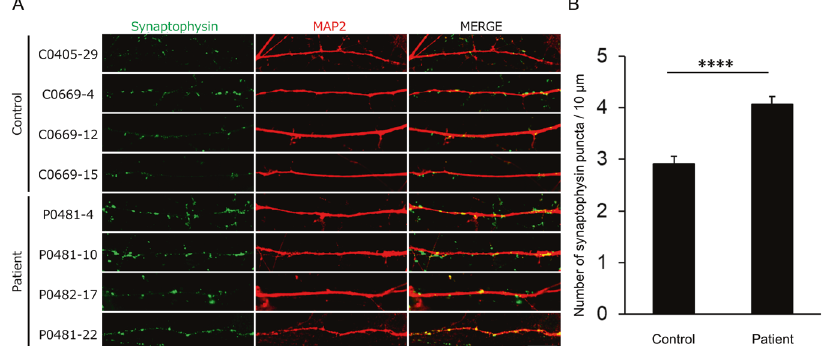
Fig. 3 Higher density of synaptophysin puncta in iPSC-derived neurons from patients. iPSC-derived neurons were cultured for 30 − 40 days for immunocytochemistry. A Representative immunostaining images of synaptophysin (green) and MAP2 (red). B Quanti fi cation of synaptophysin puncta density (control, n = 75 dendrites; patients, n = 72 dendrites). Scale bar, 10 μ m. **** P < 0.0001, Student ’ s t -test. Data were presented as mean ±